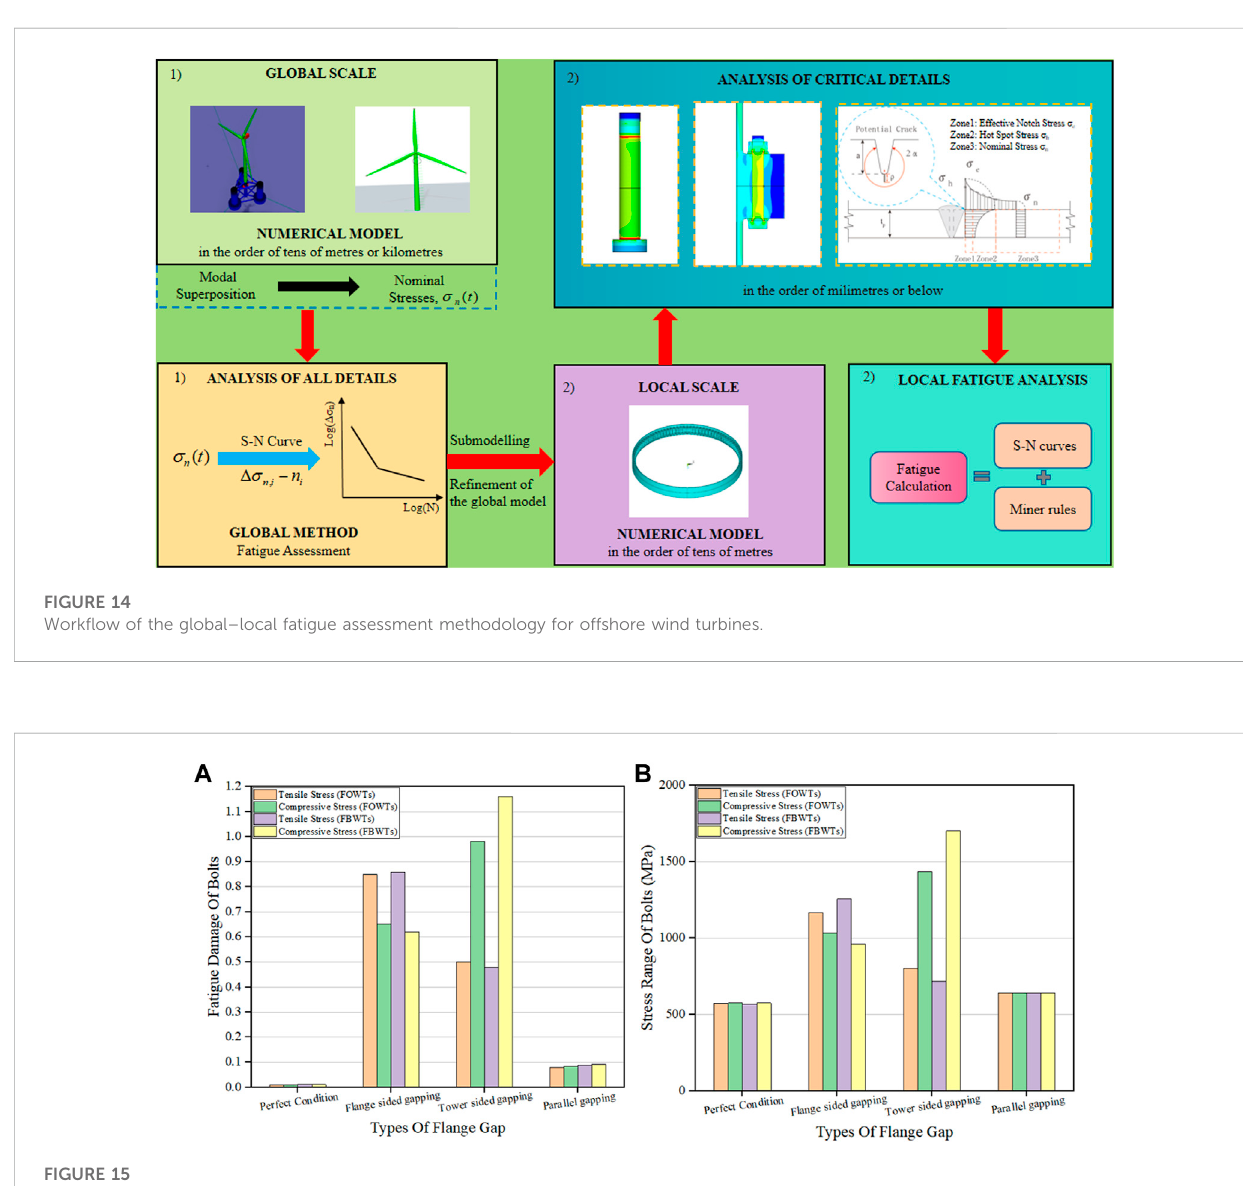
FIGURE 15 (A) Fatigue damage of OWTs ’ tower bolts under the initial fl atness divergence. (B) Stress range of OWTs ’ tower bolts under the initial fl atness